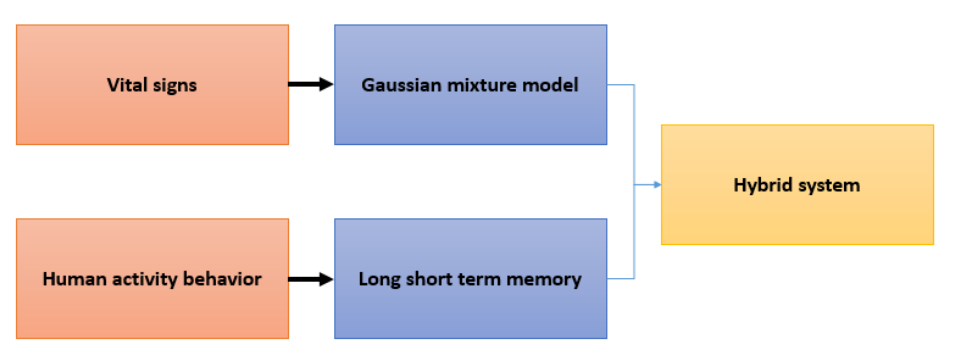
Figure 10. Data analysis through the union of a model based on anomalies and the following one based on time